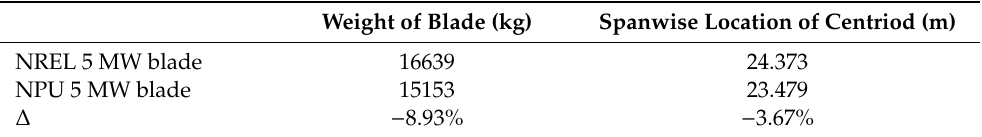
Table 8. Comparison of mass characteristics among three 5 MW blades.